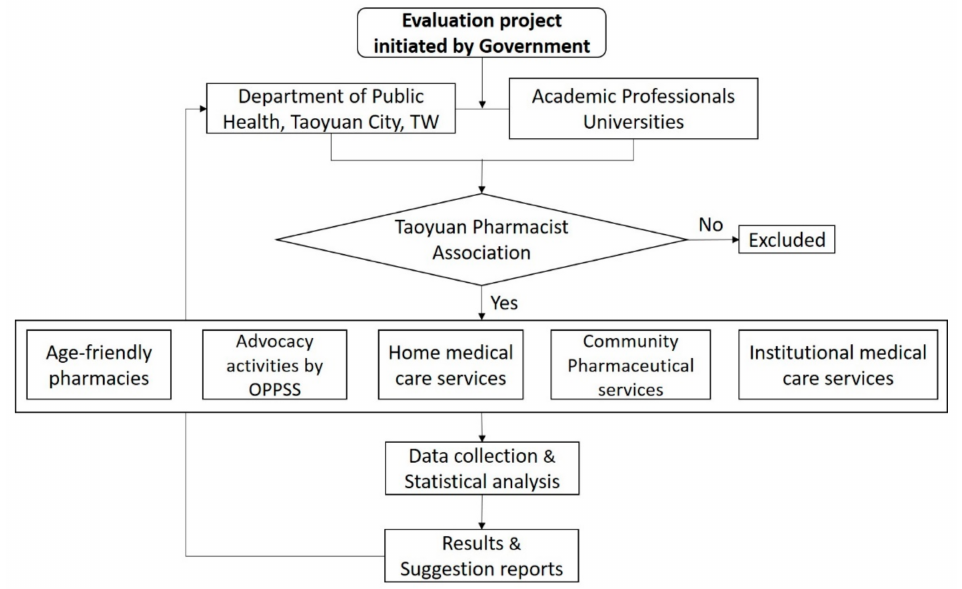
Figure 1. The research process of the study. TW: Taiwan; OPPSS: One Pharmacist Per Service